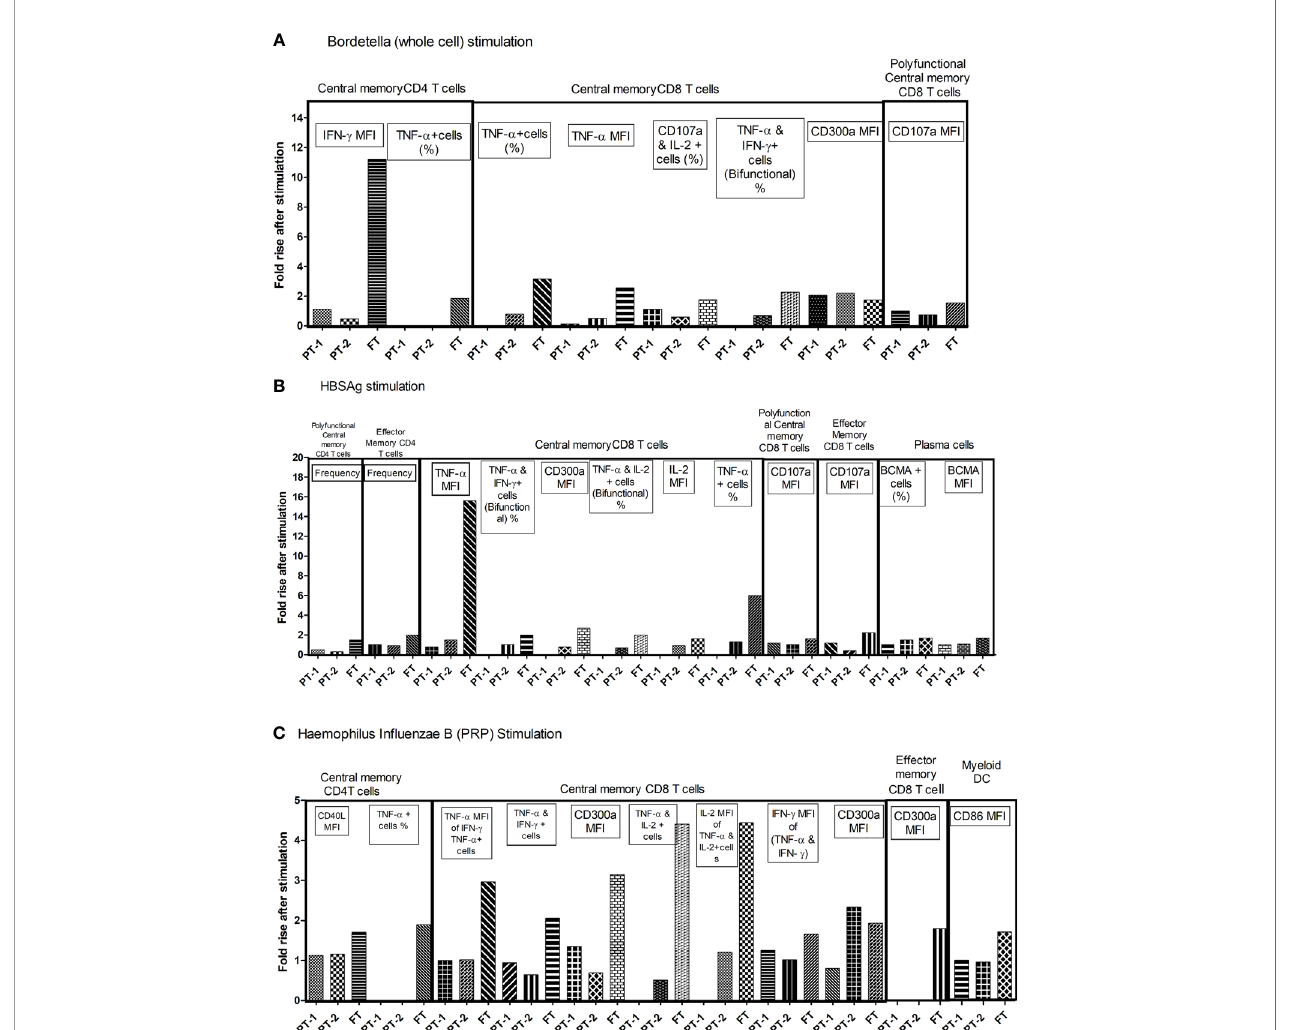
FIGURE 7 | Fold changes in functional parameters of immune cells following individual pentavalent component antigenic stimulation of cultured PBMCs. Bar diagrams in the fi gure exhibit the fold rise in frequency of immune cells and expression of different markers after short term exposure to (A) Bordetella (Whole cell) (B) HBsAg (C) Haemophilus In fl uenzae B (PRP) in all study groups. The major memory T cell types are mentioned above the lines. Fold rise in relevant parameters are shown in boxes. In recall response analyses, PBMCs of infants without any stimulation were used as controls. The cellular frequency and their phenotypic and functional characteristics obtained in unstimulated PBMCs were considered as baseline values to estimate fold changes induced by stimulation with component antigens of pentavalent vaccine. [Concentration of antigens used for stimulation-(Tetanus toxoid (3.3 LF/ml), Diphtheria toxoid (2.4 LF/ml, PRP of Hib, 1 µg/ml), HBs Ag (1 µg/ml) and the whole cell of pertussis (0.18 IOU/ml); Incubation time, 6 h]. As against signi fi cant rise (>1.5 fold) of all the indicated markers in the FT group, PT1 documented 2.06 fold (Bordetella: central memory CD8 T cells, CD300a MFI) and 2.35 fold (HiB: TNF- a , and IFN- g bifunctional central memory CD8 T cells). In PT2 infants, 2.2 fold (Bordetella: central memory CD8 T cells, CD300a MFI), 1.5 fold (HBsAg: central memory CD8 T cells, TNF- a MFI, and BCMA+ plasma cells) and 2.33 fold (HiB: central memory CD8 T cells, CD300a